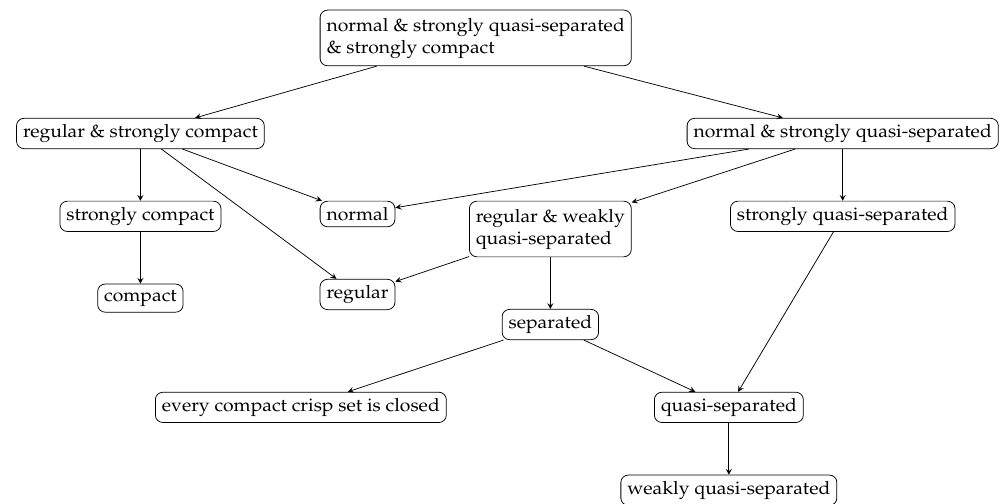
Figure 1. Relationships between the separation axioms in fuzzy topological